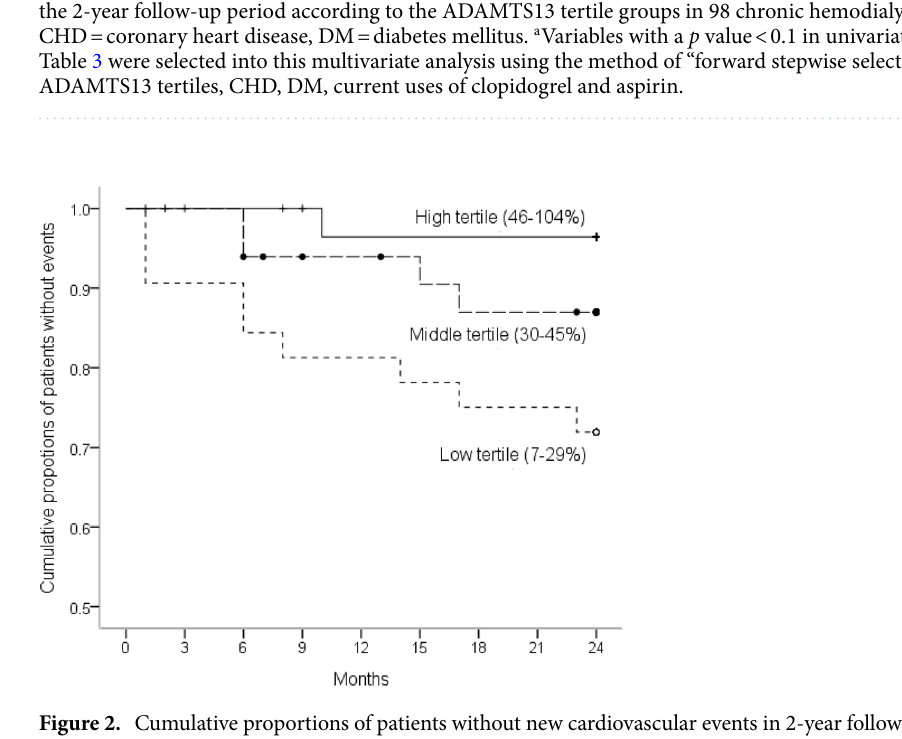
Figure 2. Cumulative proportions of patients without new cardiovascular events in 2-year follow-up period according to the tertile groups of ADAMTS13 activity, evaluated using a Kaplan–Meier survival curve, log rank test: p =